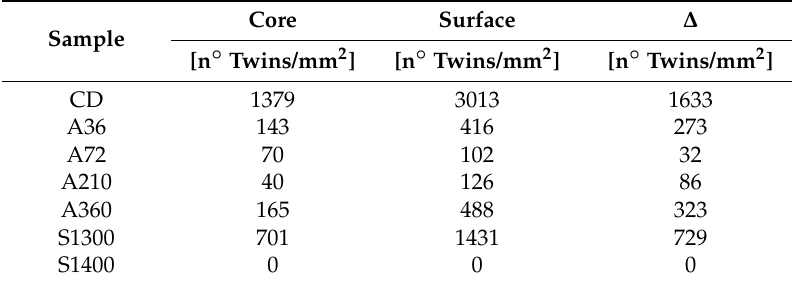
Table 8. Number of twins per